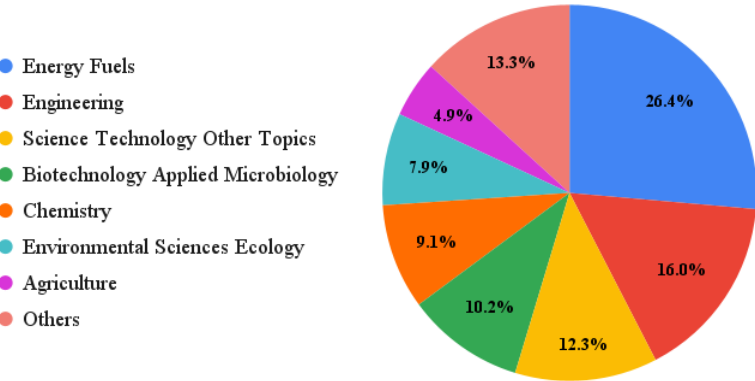
Figure 9. Distribution of research areas related to feedstock for biodiesel production.